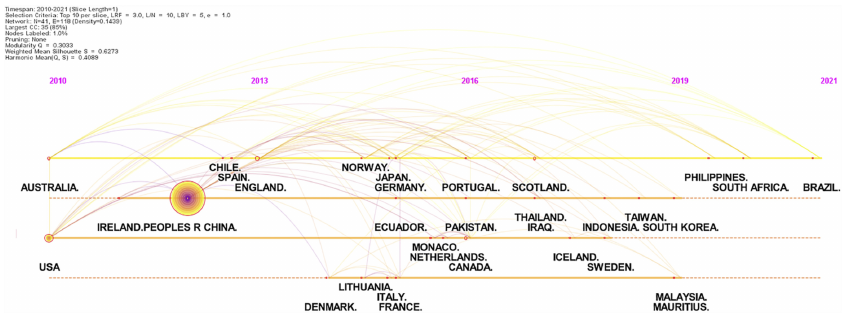
Figure 4. National cooperation network